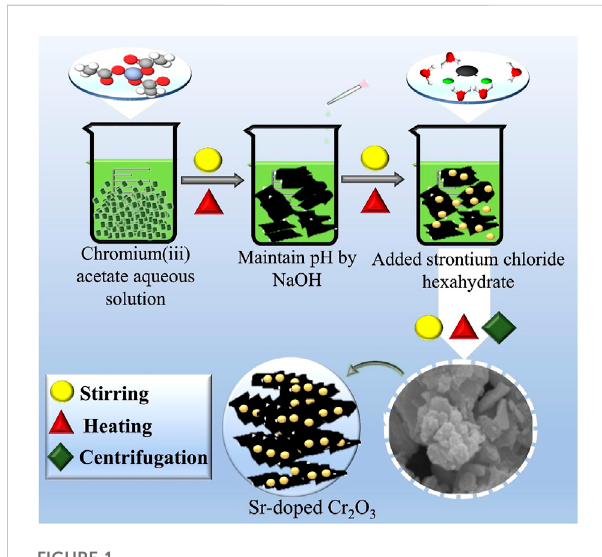
FIGURE 1 Schematic illustration for synthesis route of pristine and Sr- doped Cr 2 O 3